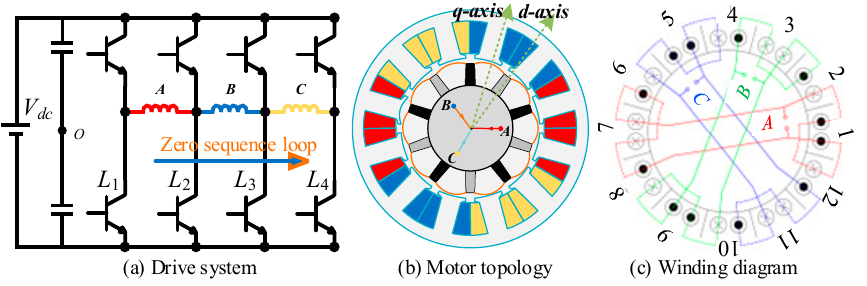
Figure 1. Drive system of series-winding PMSM.